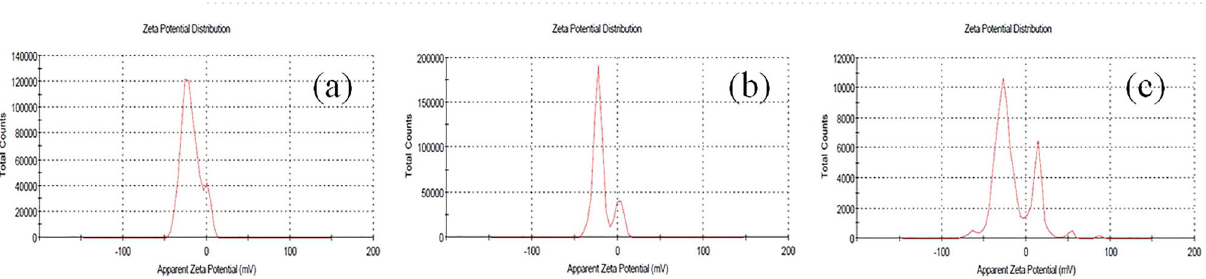
Figure 2. Zeta potential of F. cretica NPs ( a ) liposomes NP ( b ) Silver NP ( c ) Albumin